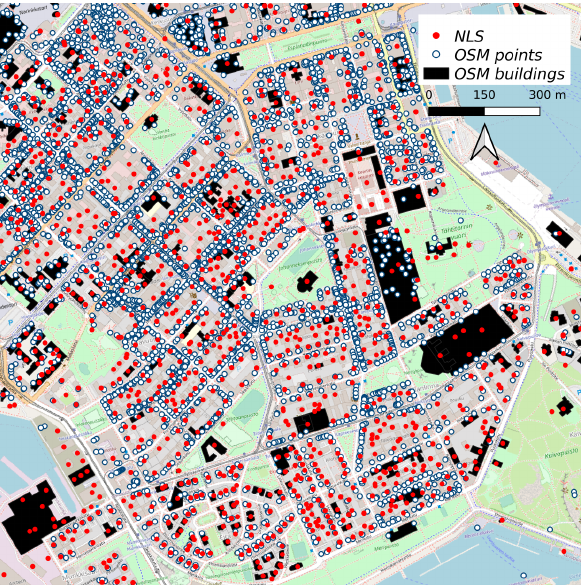
Figure 1: Example of distribution of address data in an area of Helsinki, Finland: OSM addresses associated to nodes (white points) and ways (black polygons); NLS addressed (red points). Background map: © OpenStreetMap contributors.